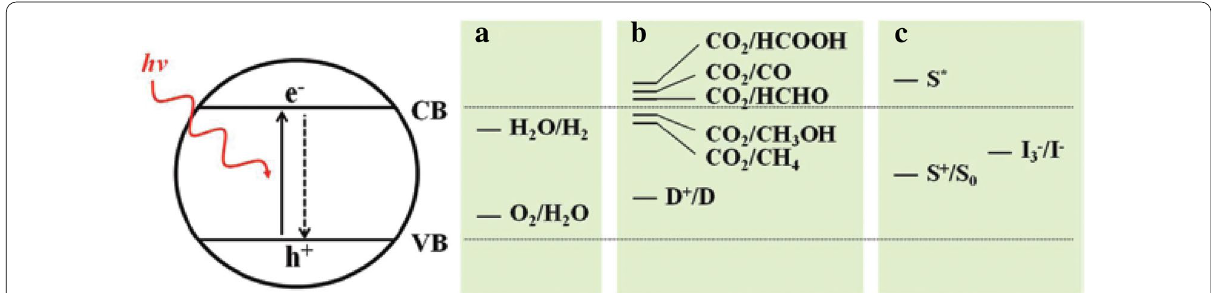
Fig. 2 Schematic illustration of TiO 2 photocatalysis and redox potentials for ( a ) water splitting, ( b ) CO 2 reduction, and ( c ) DSSCs. CB, conduction band; VB, valence band; D, donor; S, photosensitizer. Reprinted with permission from He et al. [47]. (Copyright 2012 American Chemical